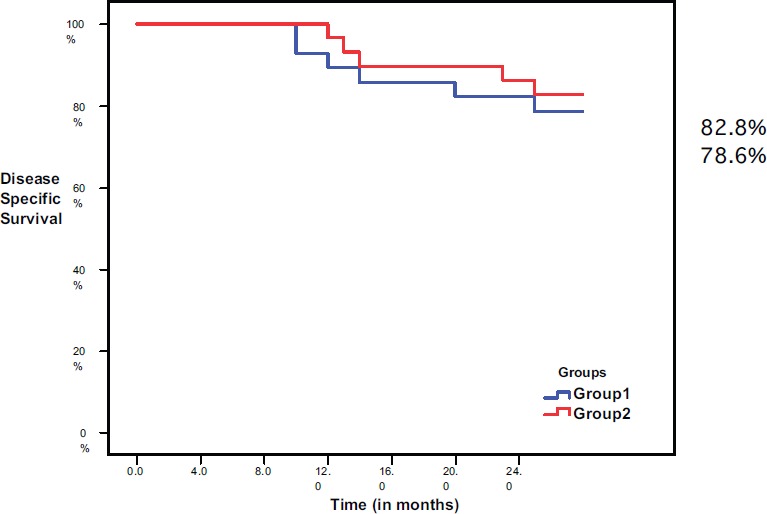
Disease-specific survival in both groups.